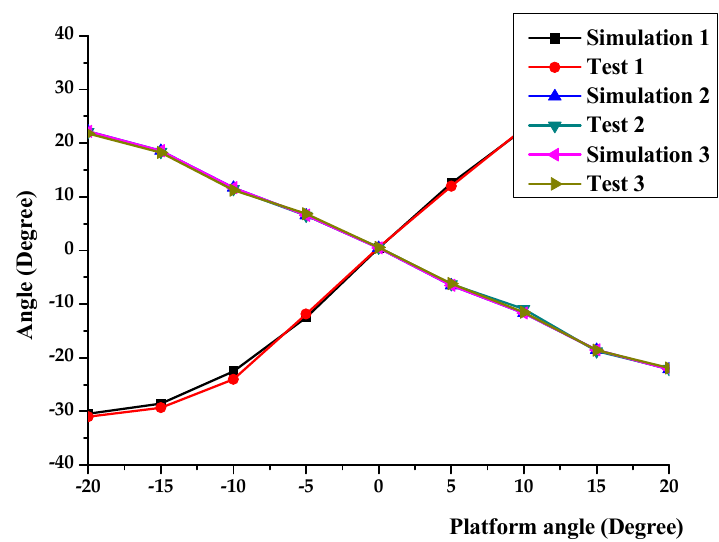
Figure 26. Comparison chart of actual and simulation of pitch motion.